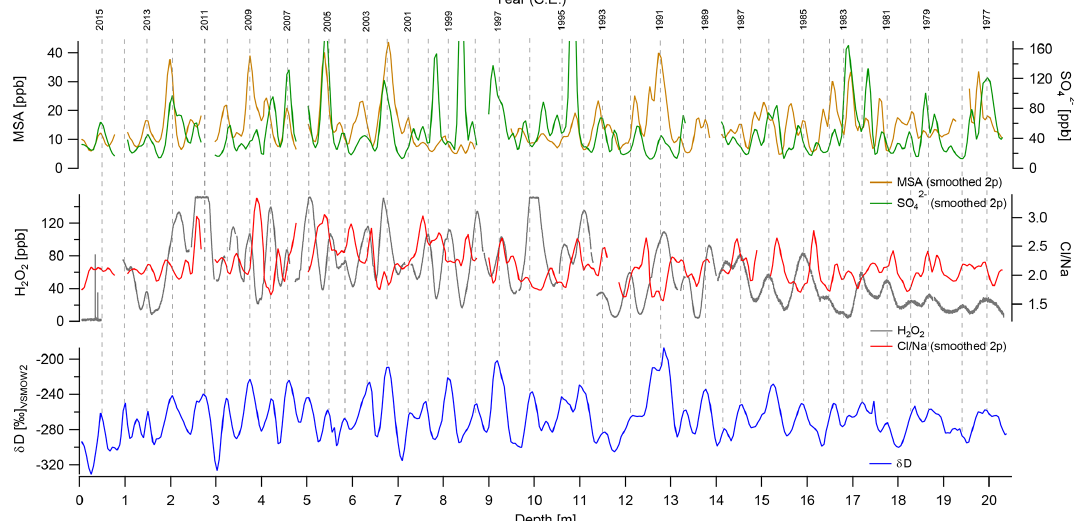
Figure 2. Age scale for firn core SCH-2 constructed by counting and inter-matching of maximum peaks (dashed lines) in CFA-derived profiles of stable water isotope composition ( δ D) and different chemical parameters (H 2 O 2 , Cl / Na, MSA and SO 2 − two-point running average. Note that the maxima of the chemical parameters do not necessarily coincide with the respective maxima in δ D due to the different seasonality of the